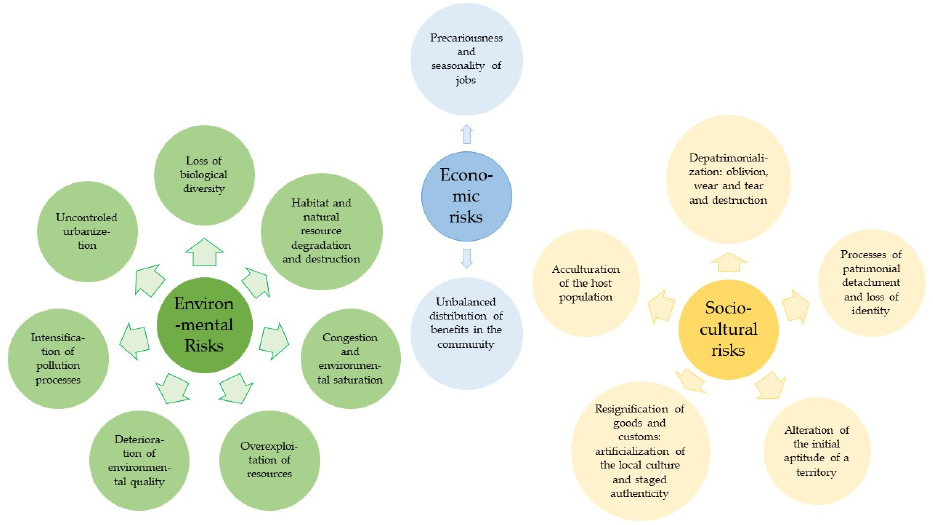
Figure 2. Tourism-related